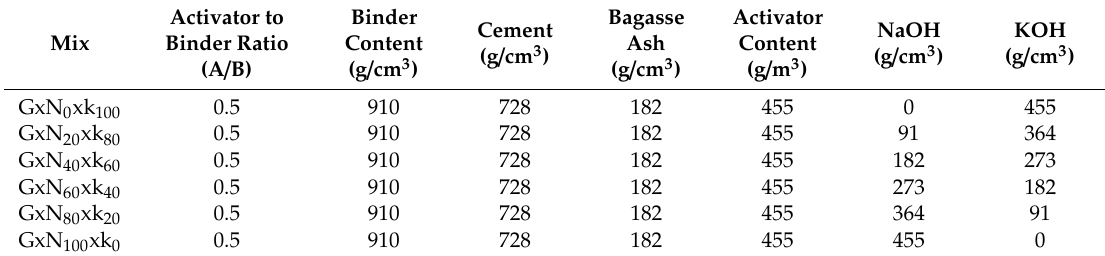
Table 3. Mix design of cement paste.